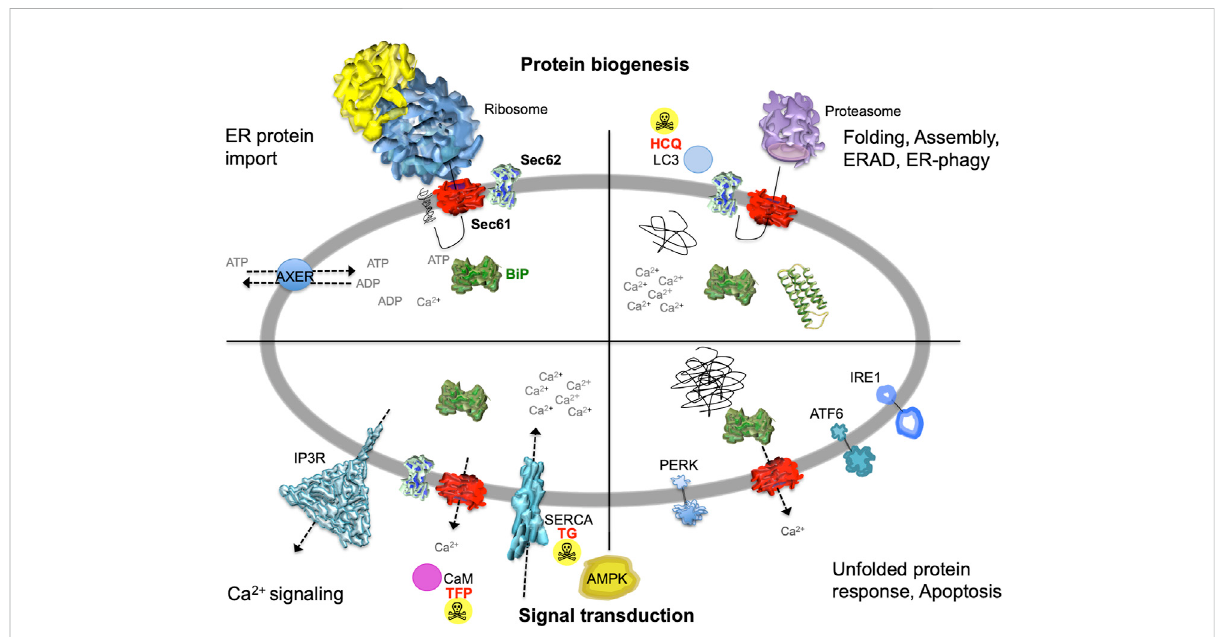
FIGURE 2 The heterotrimeric Sec61 complex, Sec62, IP3R and SERCA in the ER membrane are major players in protein biogenesis and Ca 2+ -dependent signal transductionat the ER. These proteinsare shown here in a schematic cross section of the human ER together with additional proteins and the variousfunctionsofthehumanER.Thenon-annotatedstructuresrefertoanotyet-foldedpolypeptide,anativelyfoldedprotein,andanaggregateof non-nativepolypeptides, respectively. Althoughconnectedto theUPR,anotherlevel ofcomplexity thatisrelated toenergyhomeostasisofthe ER lumen, particularly the ATP/ADP exchanger in the ER membrane (AXER/SLC35B1) and the ER to cytosol low energy signal transduction pathway, which involves cytosolic AMPK as well as Ca 2+ ef fl ux from the ER via the Sec61 channel, is not covered in this manuscript for the sake of clarity (Klein et al., 2018; Yong et al., 2019; Zimmermann and Lang, 2020; Schwarzbaum et al., 2022). AMPK, AMP-activated protein kinase; CaM, calmodulin; HCQ, hydroxychloroquine (autophagy inhibitor at the level of lysosomes); IP3R, IP3-receptor; SERCA, sarcoplasmic/endoplasmic reticulum Ca 2+ ATPase; TFP, tri fl uoperazine (CaM antagonist); TG, thapsigargin (SERCA inhibitor). The Figure and Figure legend were adapted from Melnyk et al.